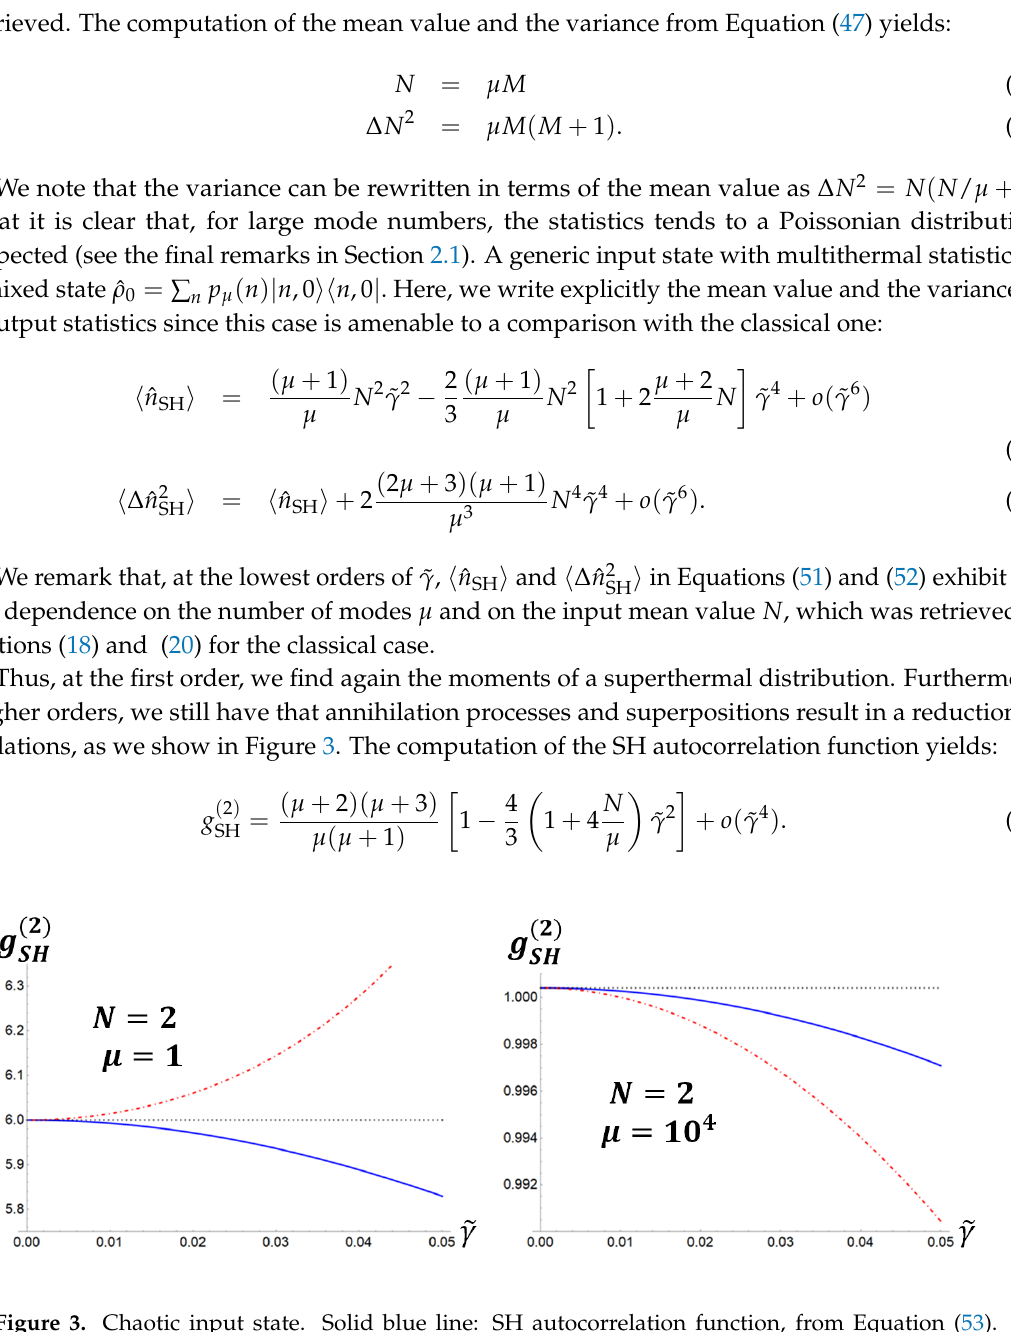
Figure 3. Chaotic input state. Solid blue line: SH autocorrelation function, from Equation (53). Dashed line: SH autocorrelation function in the absence of annihilation processes and